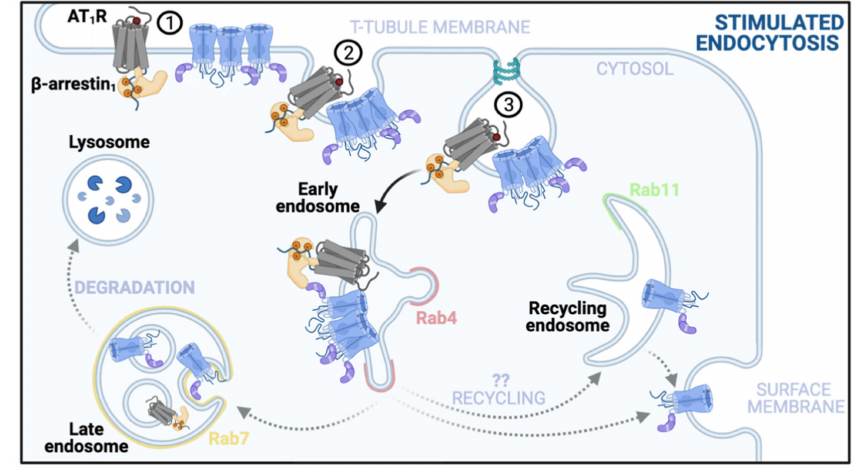
Figure 4. Angiotensin type 1 receptor stimulated endocytosis. Prolonged exposure to angiotensin II, over the course of an hour, leads to: (1) recruitment of β -arrestin 1 to t-tubule localized Ca V 1.2 channel-AT 1 R receptor complexes; (2) clathrin- coated pit formation, and (3) endocytosis. This reduces Ca V 1.2 channel expression and I Ca . The identity of the cellular compartment to which the channels are targeted upon internalization are unknown as represented by the grey dotted arrows. Their fate may lie in lysosomal degradation or they may be stored in intracellular reservoirs, or finally, as indicated by the study by Altier et al., some channels may be recycled to other membrane regions, including the surface membrane which appeared to grow more intensely positive for Ca V 1.2 immunostaining as t-tubular and dyadic expression dropped